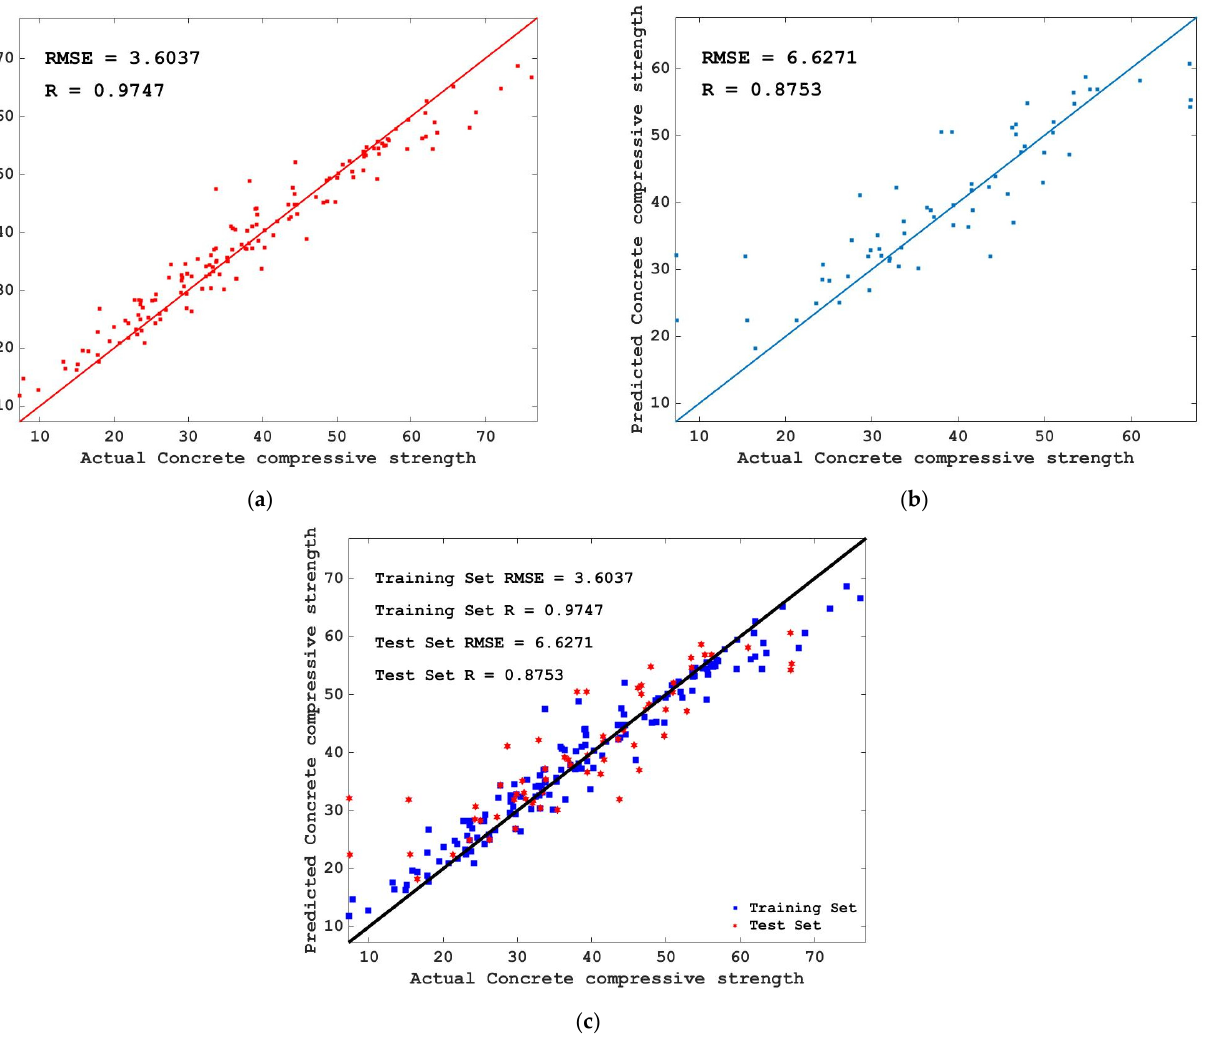
Figure 8. Comparison of predicted value and actual value of the data set. ( a ) Training set; ( b ) Testing set; ( c ) Training set and testing set.